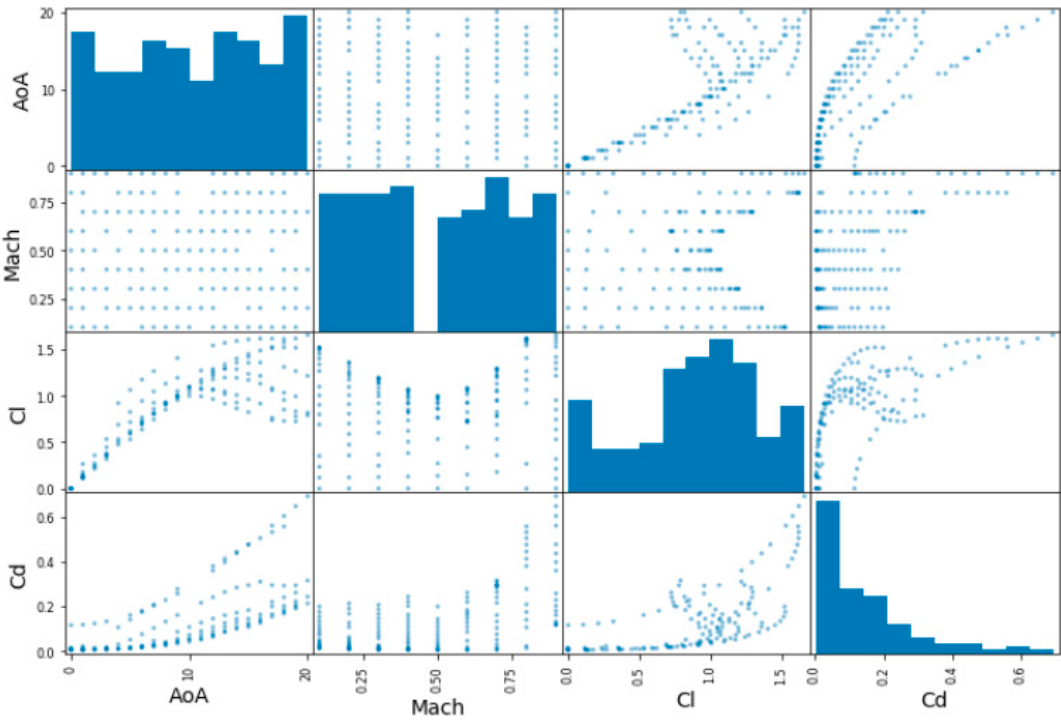
Figure 6. Exploring training set in the NACA0012 database (correlation matrix plot).